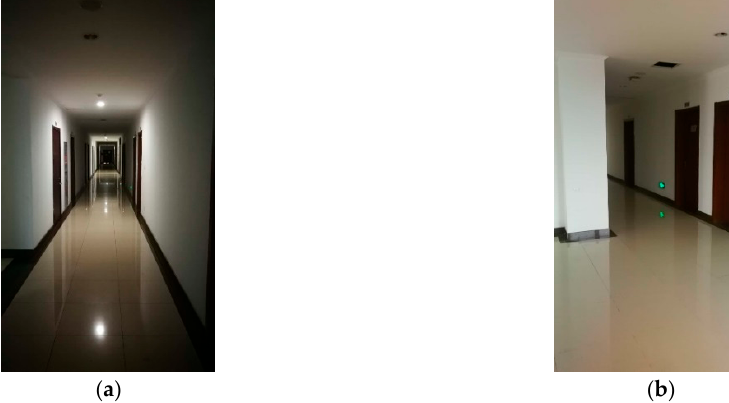
Figure 7. The Environment of Walking Experiments. ( a ) One of the corridors of experiment area; ( b ) one of the corners of the Experiment area.